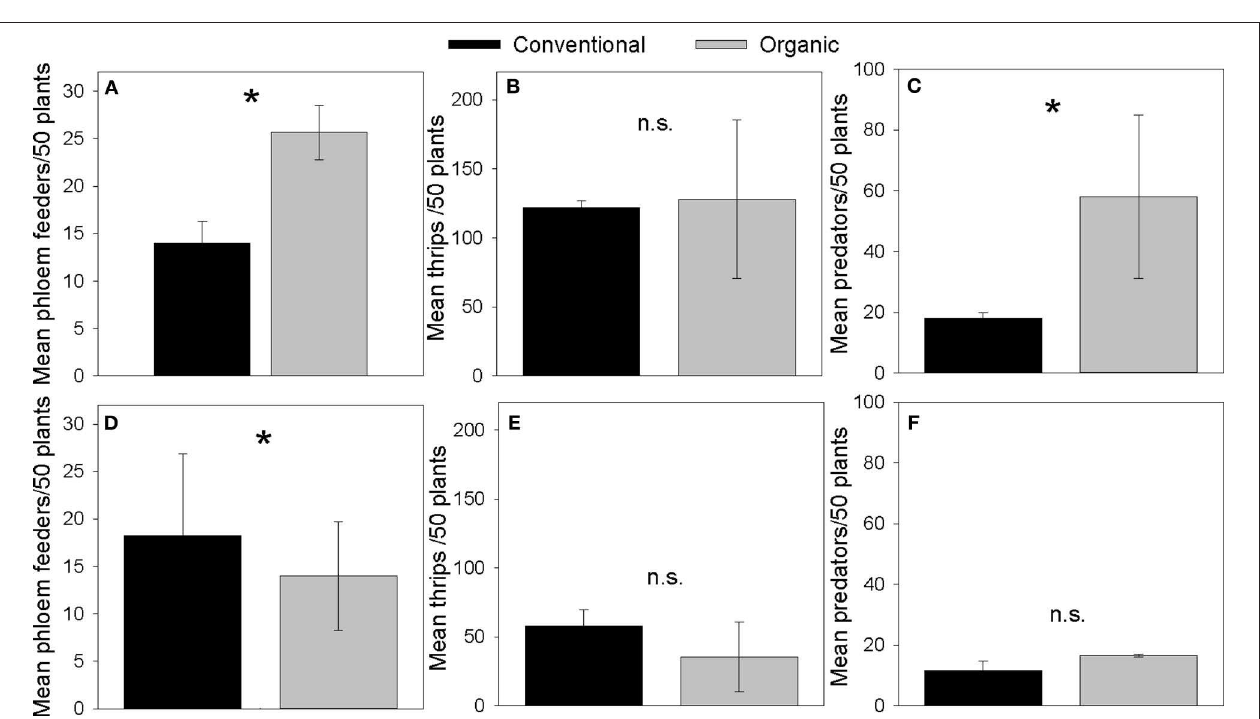
FIGURE 2 | Mean counts of phloem feeding herbivores (A,D), thrips (B,E), and natural enemies (C,F) , collected in vacuum samples from Norkotah (A–C) and Alturas (D–F) potato fields in 2015. *indicates P < 0.01.